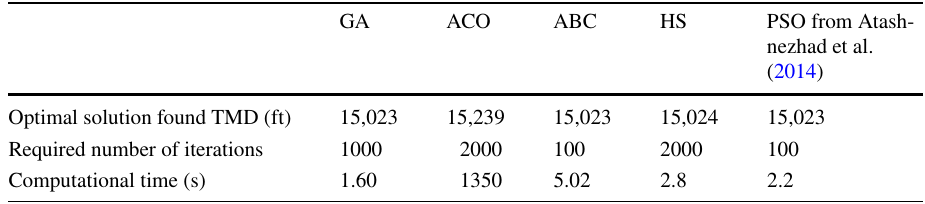
Fig. 12 Performance trends for GA, ABC and HS algorithms applied to the wellbore optimi- zation Case 1 for 400 iterations. GA and HS may require more iterations to be fully converged